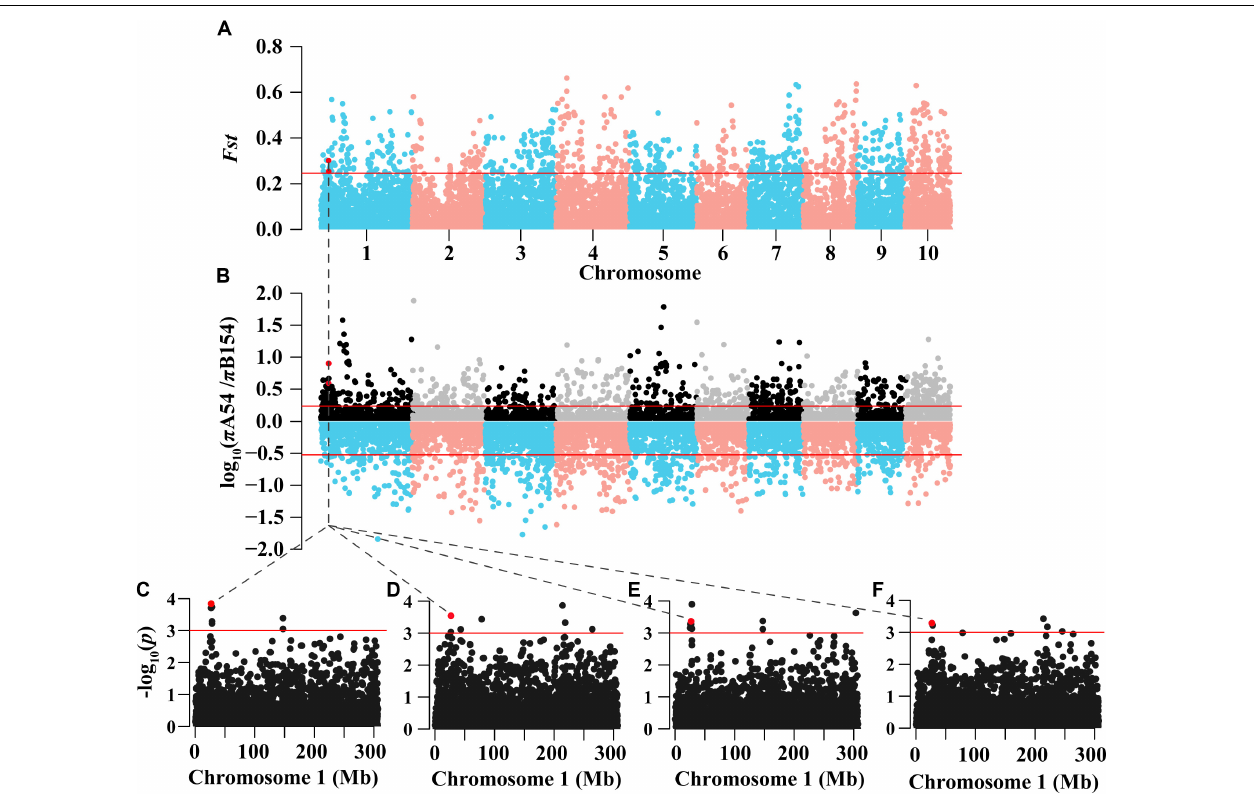
FIGURE 2 | Genomic regions through long-term artificial selection in AM208 and Manhattan plot of EL and FL in Chromosome 1. (A) Distribution of genetics differentiation ( Fst ) values. (B) Distribution of nucleotide diversity ( π ) ratio ( π A54/ π B154). These values are calculated in 100kb sliding windows. Red lines represent the 90% tails of the empirical distribution of each stastic. (C) Region plot of EL in E1. (D) Region plot of EL in E2. (E) Region plot of FL in E1. (F) Region plot of FL in